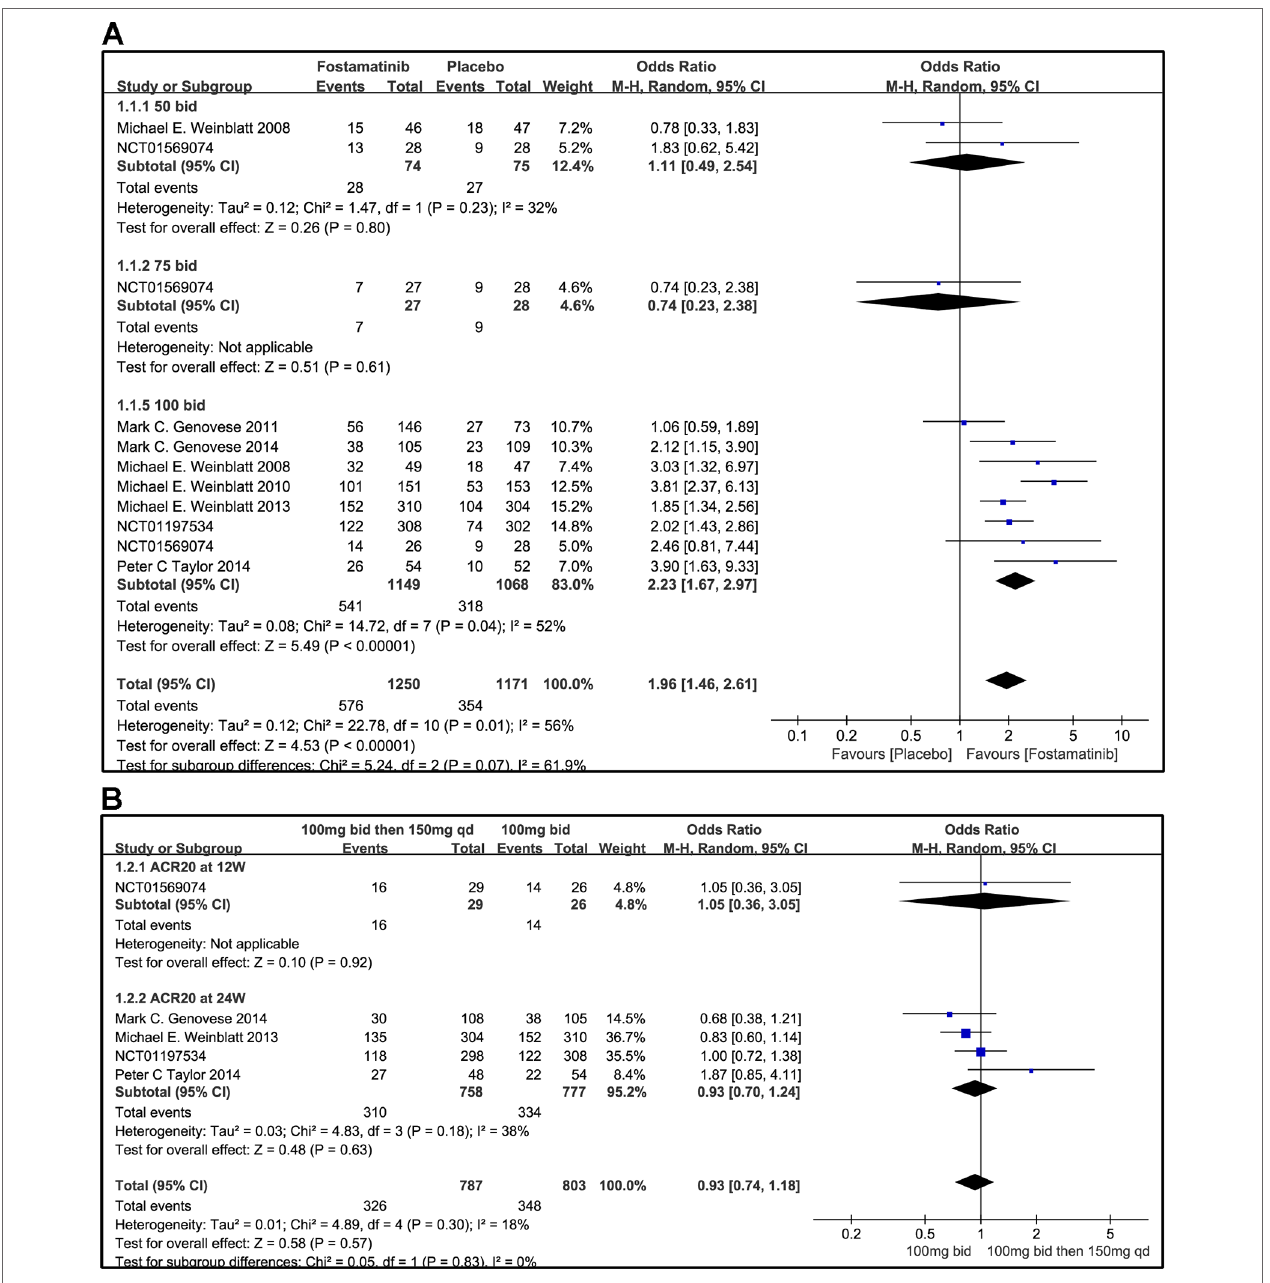
FIGURE 3 | Forest plots for the effect of multiple doses on ACR20 at different time points. (A) Subgroups administered multiple doses (50, 75, and 100 mg bid) of fostamatinib vs. placebo at 24 weeks from baseline; (B) 100 mg bid for 4 weeks followed by 150 mg bid vs. 100 mg bid at 12 and 24